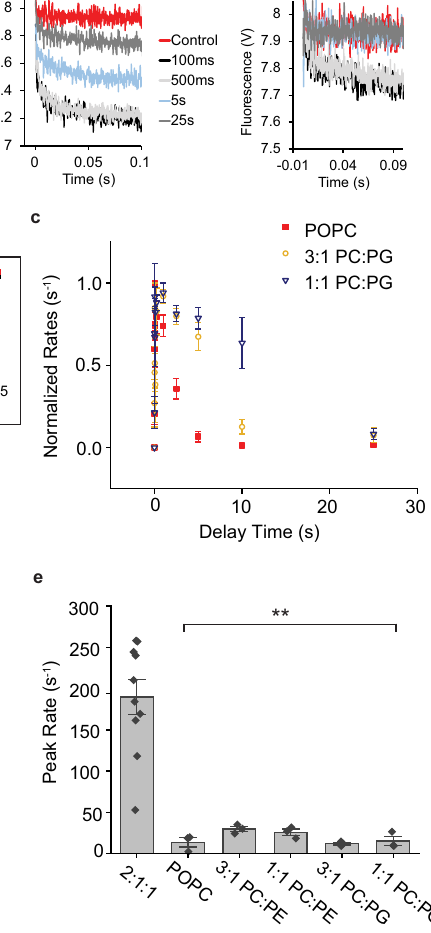
rates ofWT ELIC in POPC, 3:1 POPC:POPG and 1:1 POPC:POPG asa function of time aftermixingwith10mMpropylamine( n =3). d Weightedtimeconstantforthetime courseofdesensitizationinresponseto10mMpropylaminefromtheTl + fl uxassay for the indicated liposome compositions ( n =3). 2:1:1 indicates 2:1:1 POPC:POPE:- POPG. e Same as c showing peak channel activity (rate) in response to 10mM propylamine from the Tl + fl ux assay (2:1:1, n =12; other, n =3). Statistical analysis was performed using a one-way ANOVA and post-hoc Tukey test. ** indicates p <0.01 when comparing 2:1:1 with all other liposome compositions. P -values for these comparisons with 2:1:1 are 0.003 for POPC, 0.006 for 3:1 PC:PE, 0.005 for 1:1 PC:PE,0.002for3:1PC:PGand0.003for1:1PC:PG.Dataareshownasmean±sefor (n) independent experiments. Source data are provided as a source data fi